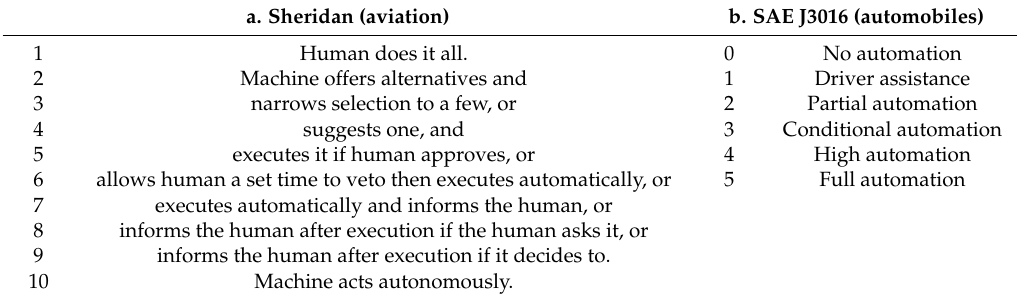
Table 3. Prominent automation/autonomy scales (after Reference [15] and from Reference